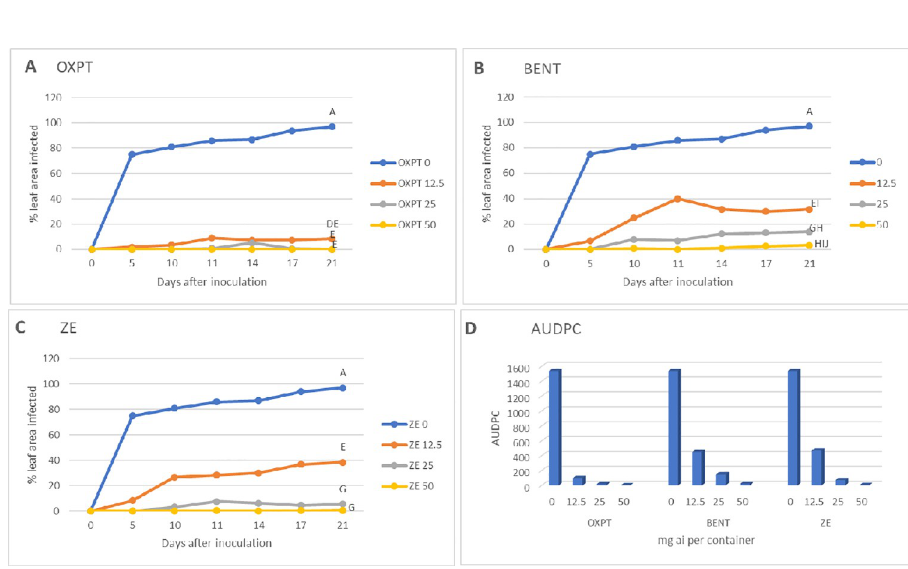
Fig 6. Systemic protection of potato Sifra against late blight caused by an MFX-resistant isolate of Phytophthora infestans under field conditions. Potato plants grown in 64 L containers were treated by a soil drench of 12.5, 25, or 50 mg ai fungicide suspension per container (n = 3). At 25 days after treatment the plants were inoculated with a sporangial suspension of isolate 164 of this pathogen. Percent leaf area occupied by late blight lesions was visually recorded at various time intervals after inoculation. Different letters on the curves indicate on significant differences between treatments (n = 3) at 21 dpi (t-test, α = 0.05). A- oxathiapiprolin. B- Benthiavalicarb. C- Zorvec Endavia. D- Area under disease progress curve.